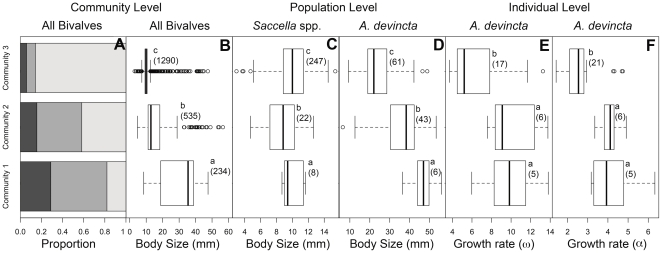
Bivalve body size and growth rate changes over time.(A) Proportion of bivalves that are suspension feeders (dark gray), surface deposit-feeders (medium gray), and subsurface deposit-feeders (light gray), (B) community-level body size, (C) Saccella spp. body size, (D) Anadara devincta body size, and (E) average growth rate (ω) of A. devincta based on external growth breaks and (F) average growth rate (α) of A. devincta based on external growth breaks in each of the three molluscan community states. Lower case letters to the upper right of each box plot denotes significant differences (Mann-Whitney, p<0.05). Homogenous groups within each panel are indicated by the same letter. Numbers in parenthesis are the number of individuals represented in each box plot.